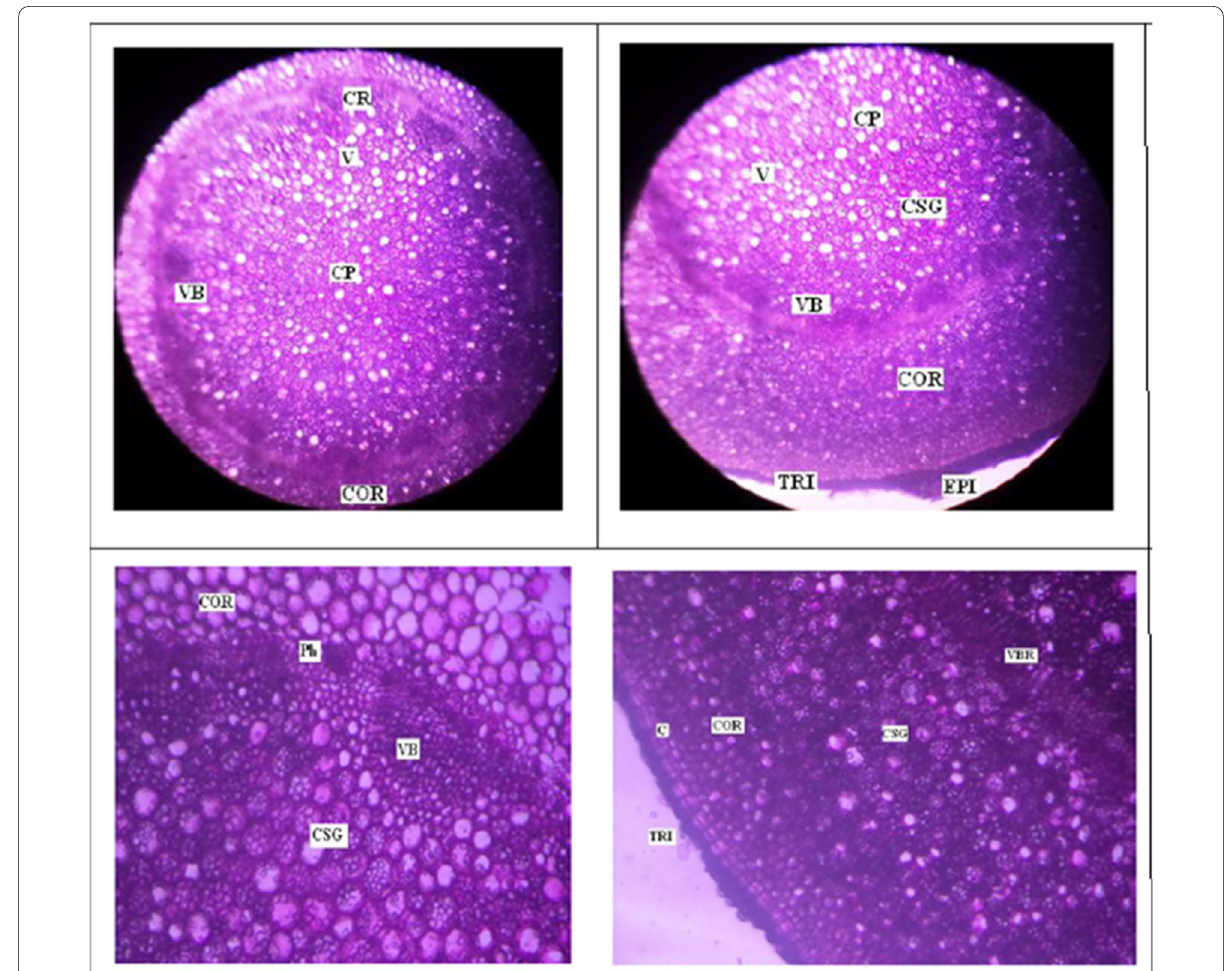
Fig. 6 The transverse sections of stem of B. pinnatum. T.s of plant showed the presence of vascular bundles, cortex, trichomes, starch grains as diagnostic charcateristics